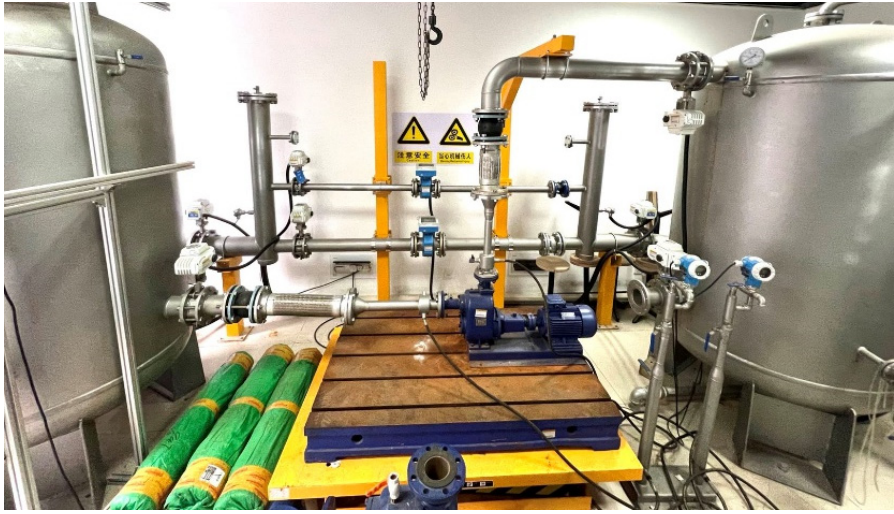
Figure 2. The experimental system for measuring the centrifugal pump efficiency. Table 1. Information of measuring